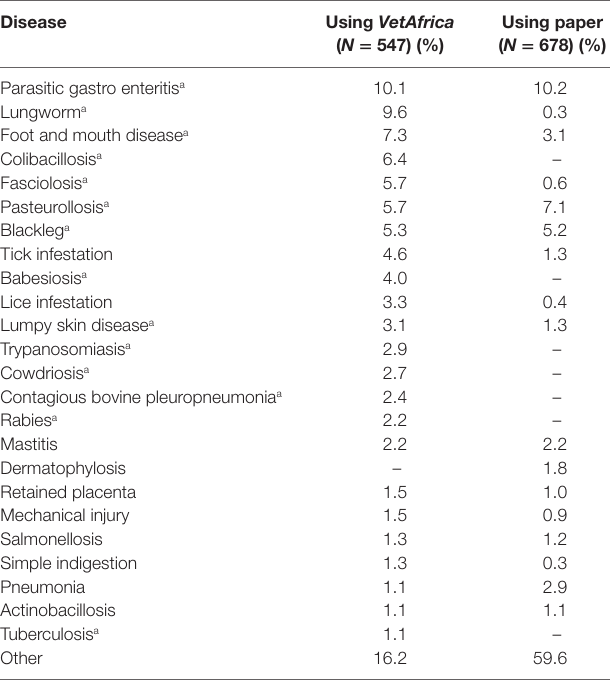
TaBle 2 | List of most commonly occurring diseases in cattle, as diagnosed by the student practitioners, and their proportional morbidity based on the two reporting